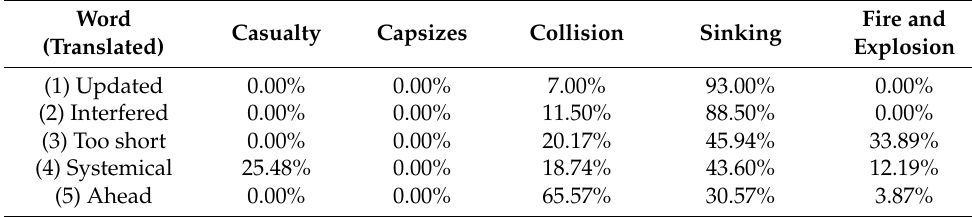
Table 7. Latent-cause words in complex collision accidents in the category of “sinking.”